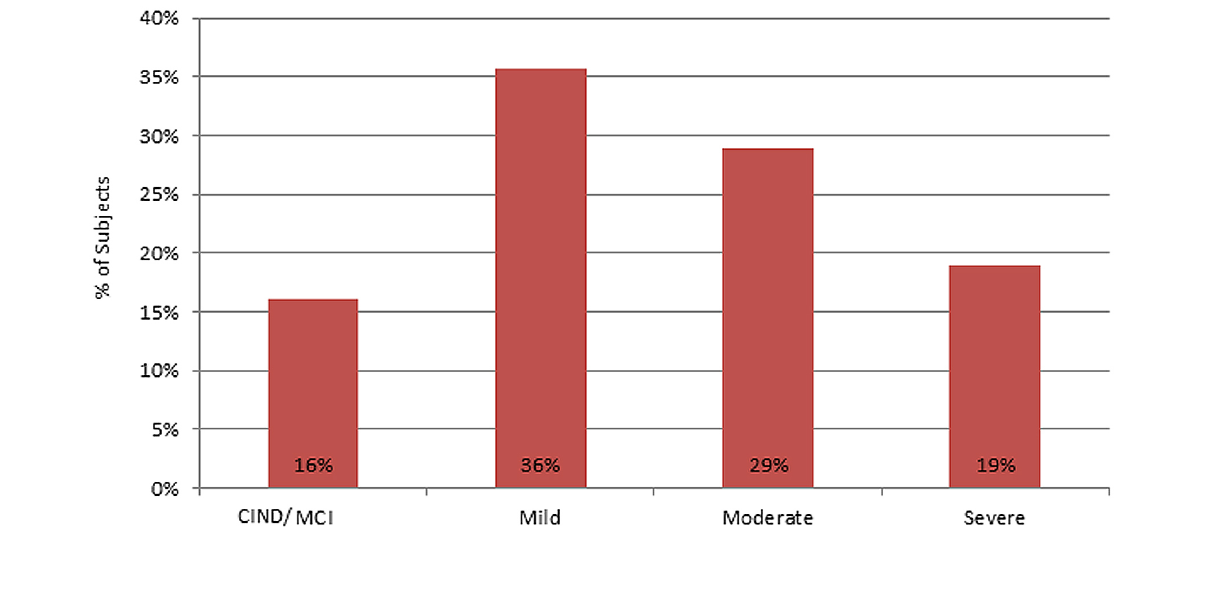
Figure 2. Distribution of Web-based users by clinical stages as classified by the ANN model staging algorithm